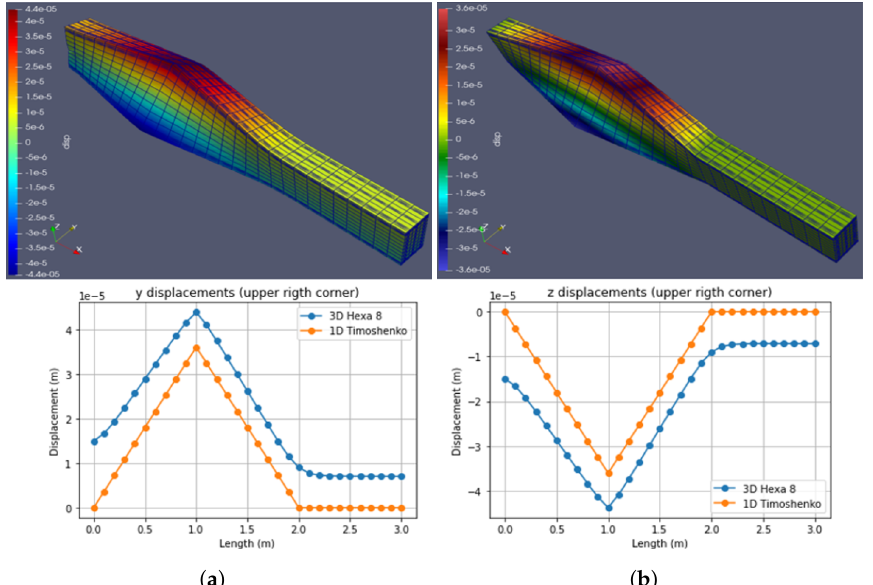
Figure 18. Case 5: Torsional load at L = 1 m (2800 N.m). ( a ) Hexa8. ( b ) Timoshenko. (Note: e − n indicates 10 − n ).